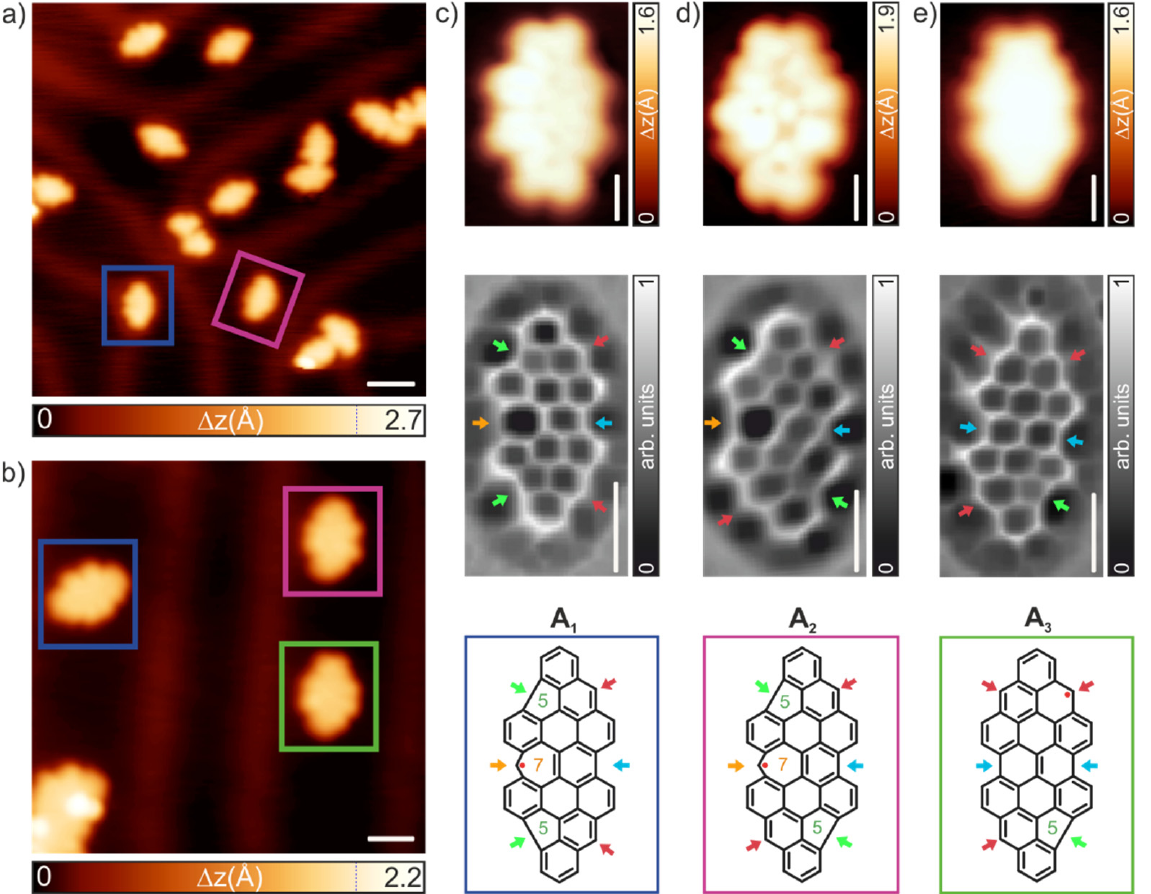
Figure 1. Synthesis and structural characterization of non-benzenoid NGs on Au(111). ( a , b ) Overview STM images of the Au(111) surface after sublimation of P and subsequent annealing at 200 °C. Scanning parameters: ( a ) V b = − 1.5 V, I t = 10 pA and ( b ) V b = − 1.5 V, I t = 100 pA. ( a , b ) Scale bars = 2 and 1 nm, respectively. ( c – e ) High-resolution STM images (top row) and constant-height frequency-shift nc-AFM (middle row) acquired with a CO-functionalized tip, together with the corresponding non-benzenoid non-Kekulé chemical structure (bottom row) of A 1 ( c ), A 2 ( d ) and A 3 ( e ). The colored rectangles of the distinct NGs correspond to the colored ones in ( a , b ) (blue ( A 1 ), violet ( A 2 ), and green ( A 3 )). The colored arrows highlight the formation of new rings as described in the main text. STM parameters: V b = 5 mV, I t = 30 pA, all scale bars = 0.5 nm. Nc-AFM parameters: Z offset = 150 pm above the STM set point (5 mV, 50 pA), scale bars = 1 nm.